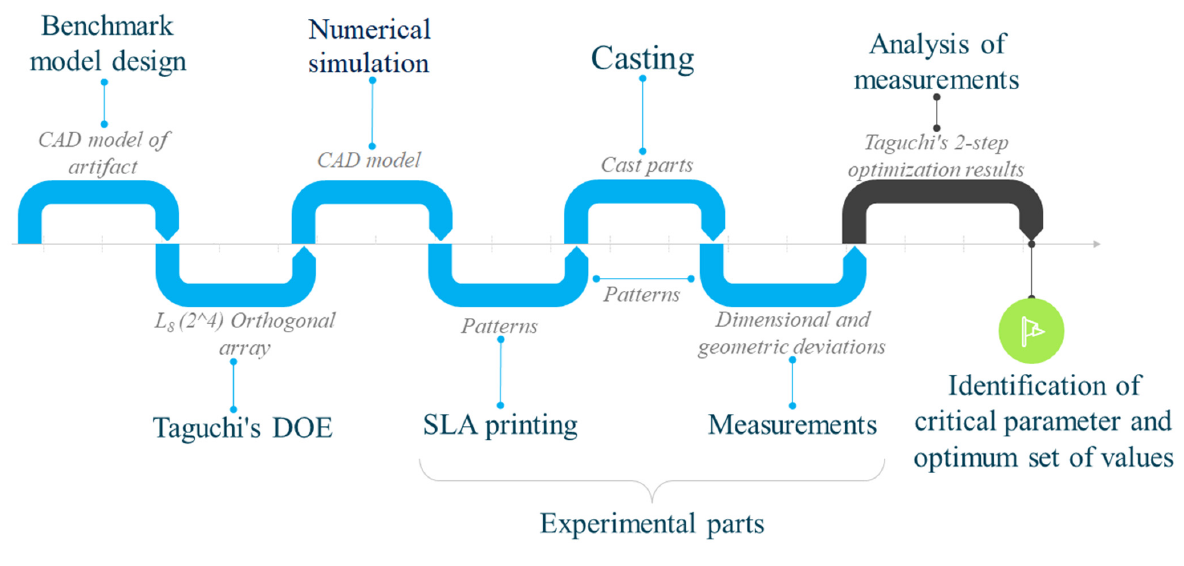
Figure 1. Methodology workflow.